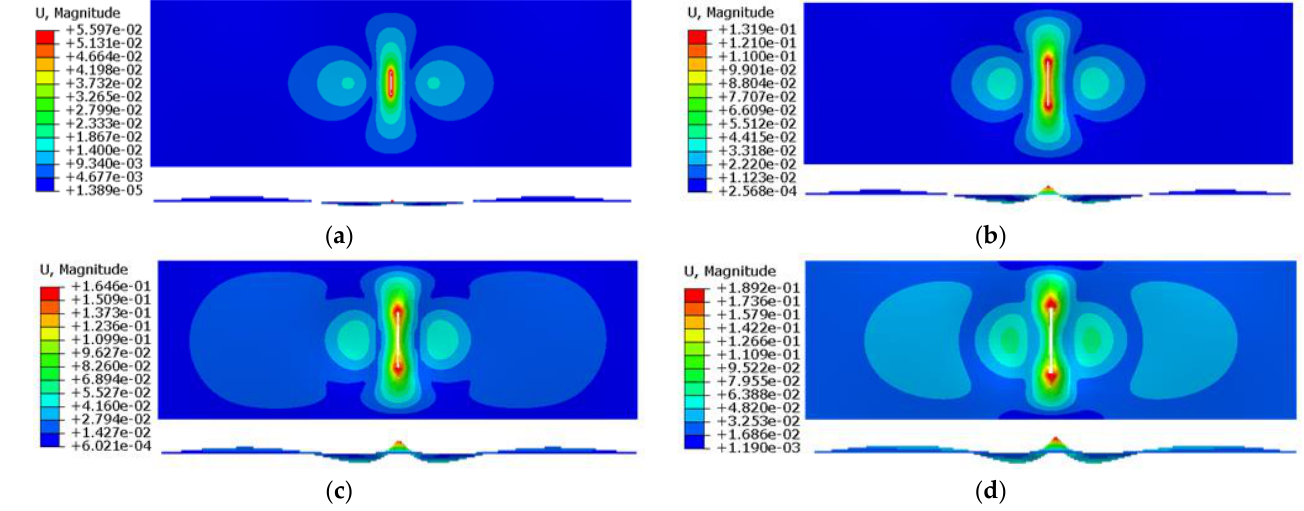
Figure 13. Out-of-plane deformation distribution of cracked plate at minimum load: ( a ) ∆ c = 30 mm; ( b ) ∆ c = 90 mm; ( c ) ∆ c = 120 mm; ( d ) ∆ c = 150 mm.